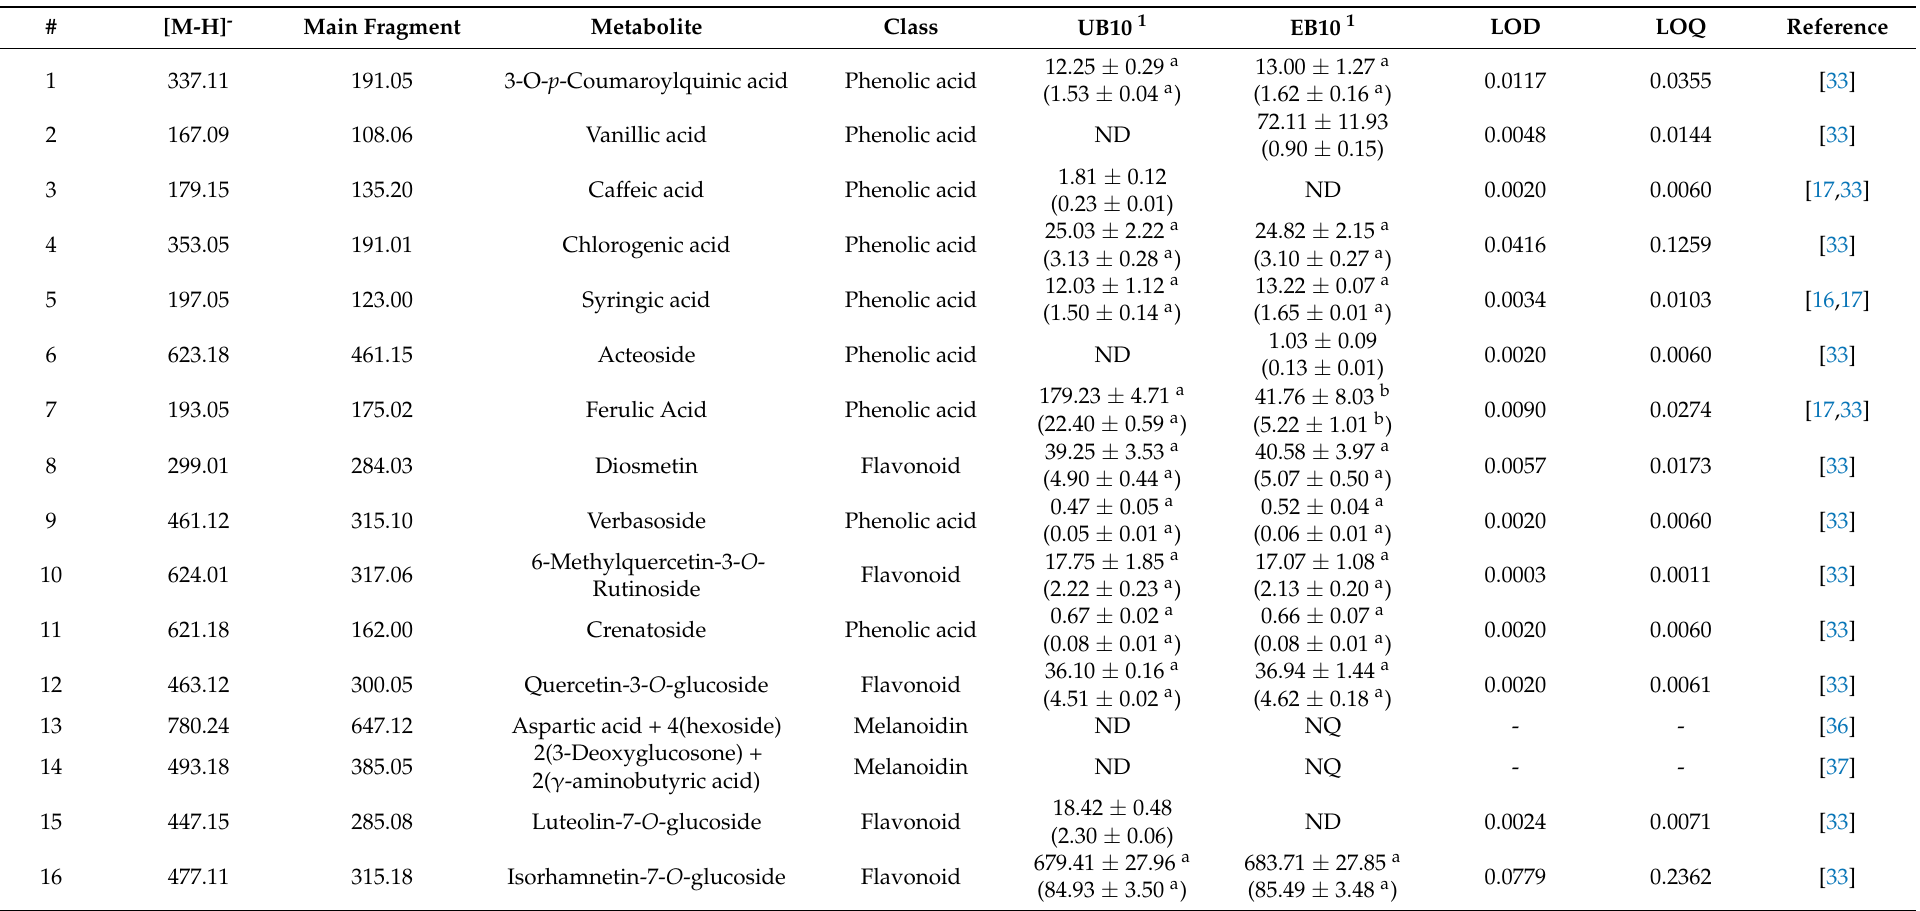
Table 1. Phytochemical compounds found in extracts of unprocessed and extruded sesame seeds byproduct flour